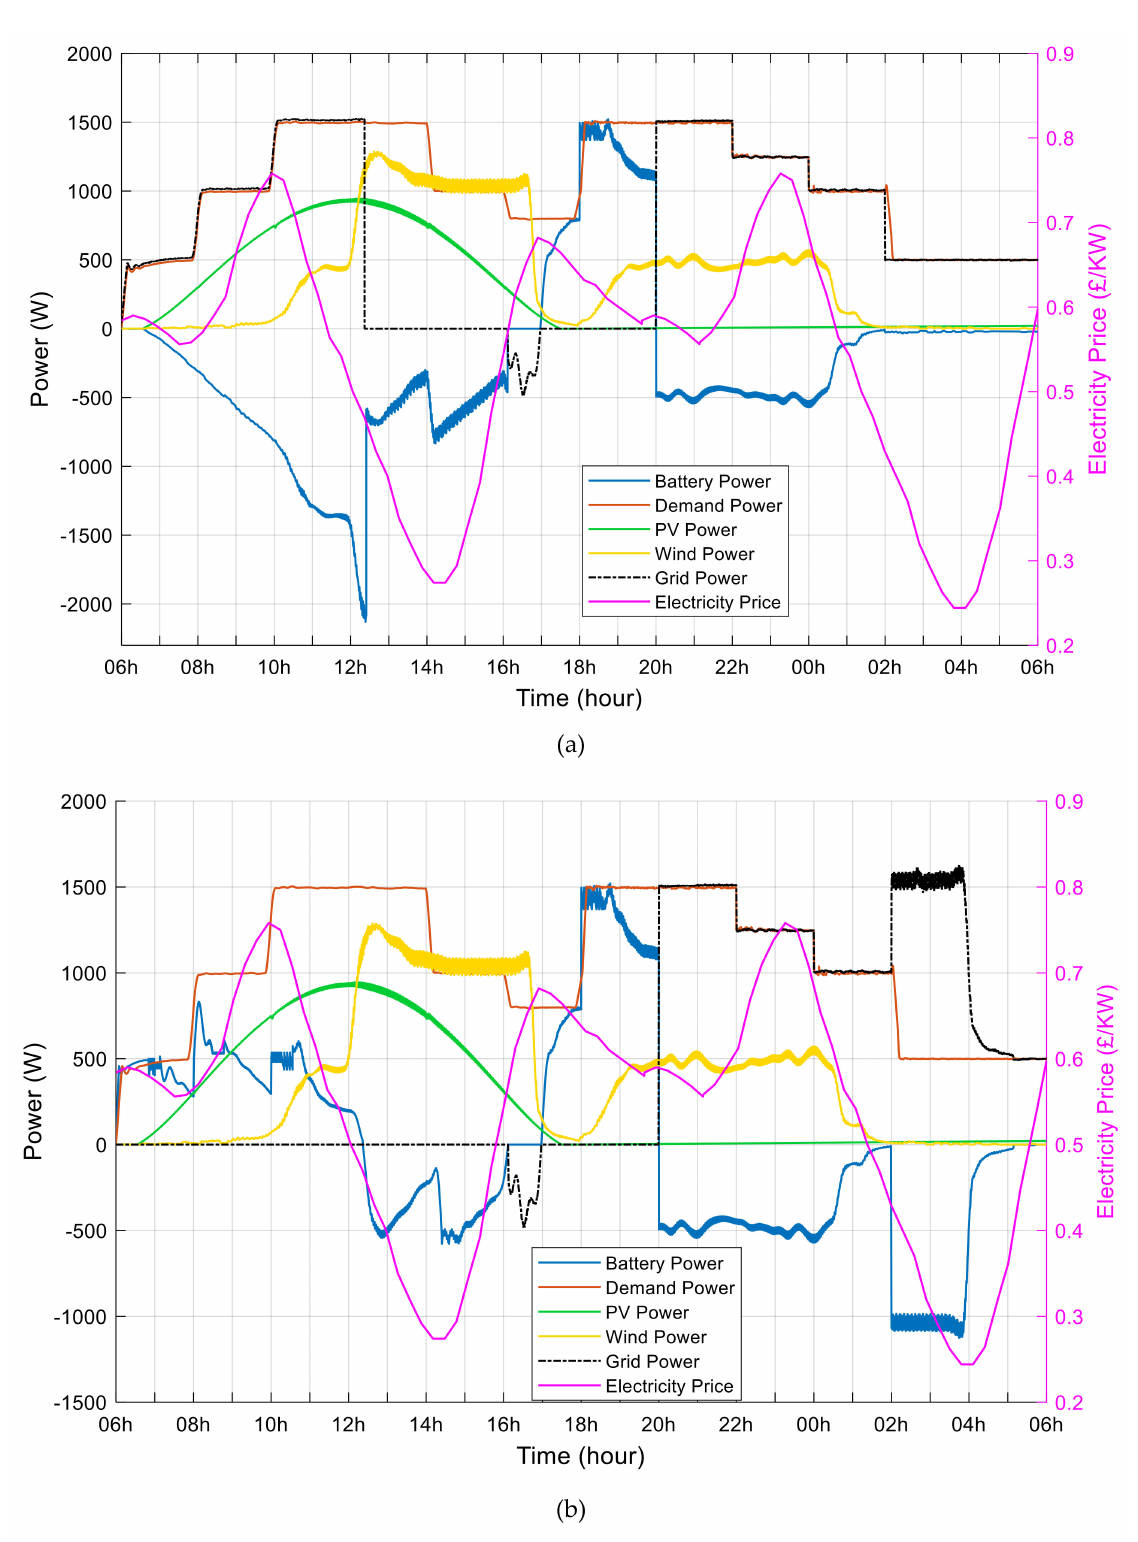
Figure 12. Energy management scenarios based on GPC model, ( a ) Case 1: without battery-grid interaction, ( b ) Case 2: with battery-grid